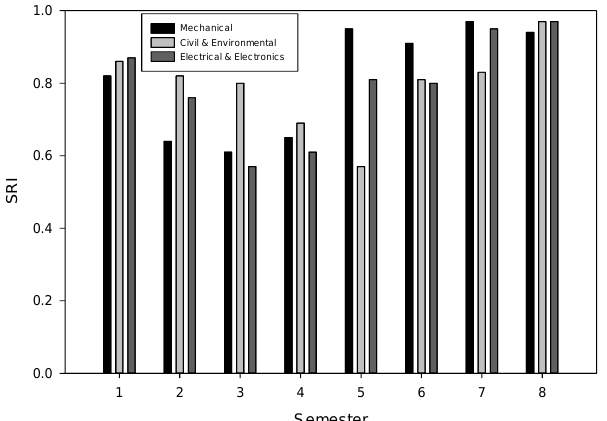
Figure 2. Relaxation index for each semester in the study plan for the Electrical & Electronics, Civil & Environmental, & Mechanical Engineering at the University of Sharjah (UOS)